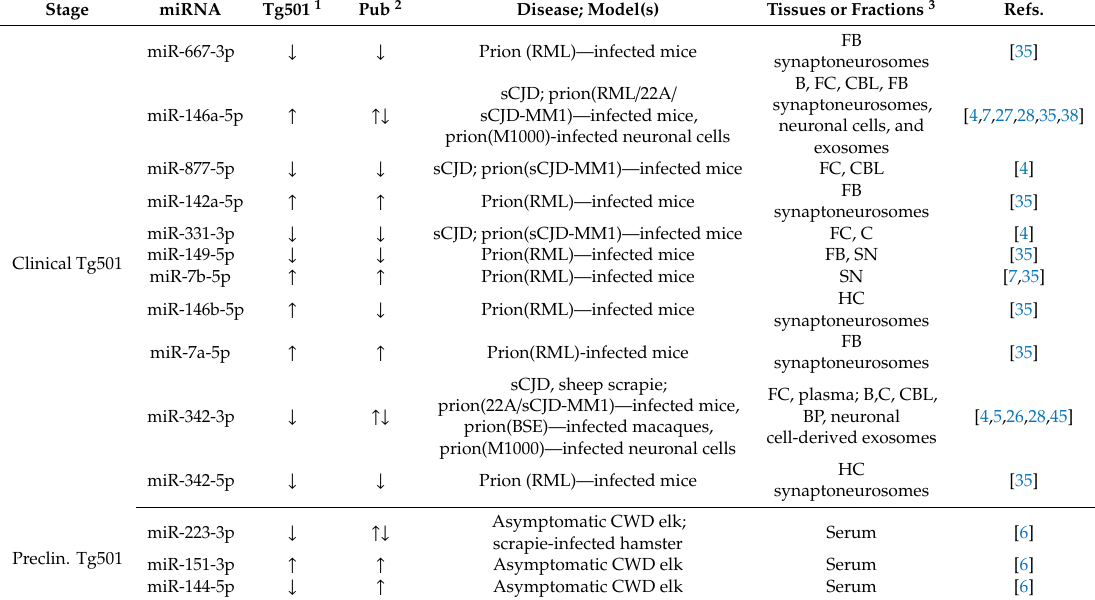
Table 4. Tg501miRNA alterations described earlier in the context of prion